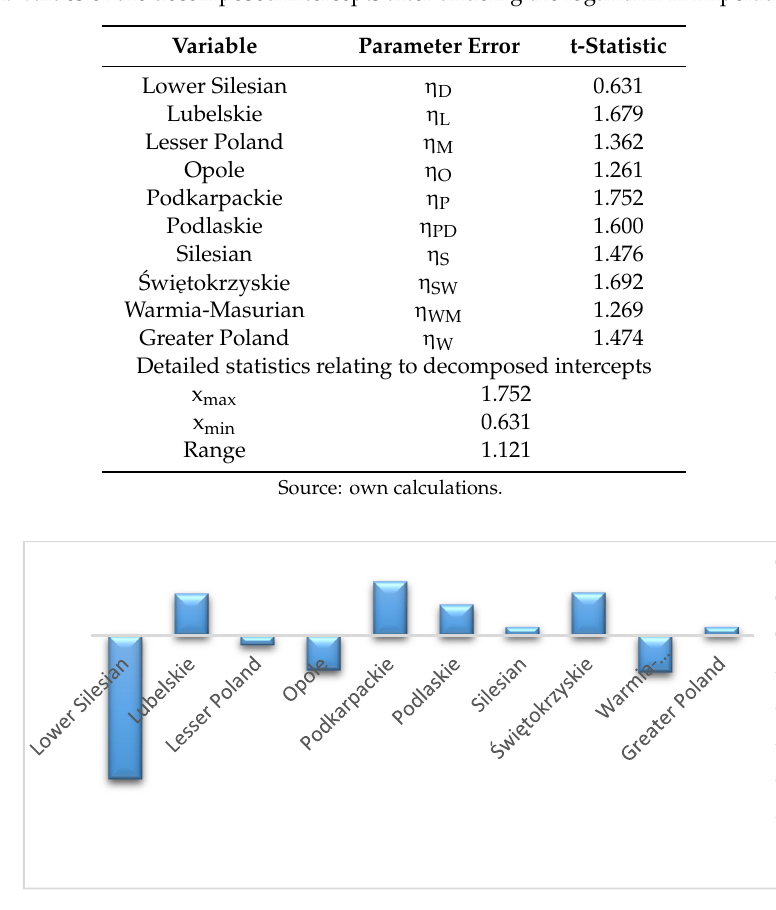
Figure 1. Di ff erences in the levels of decomposed intercepts in imperative DLT. Source: own Figure 1. Differences in the levels of decomposed intercepts in imperative DLT. Source: own study.